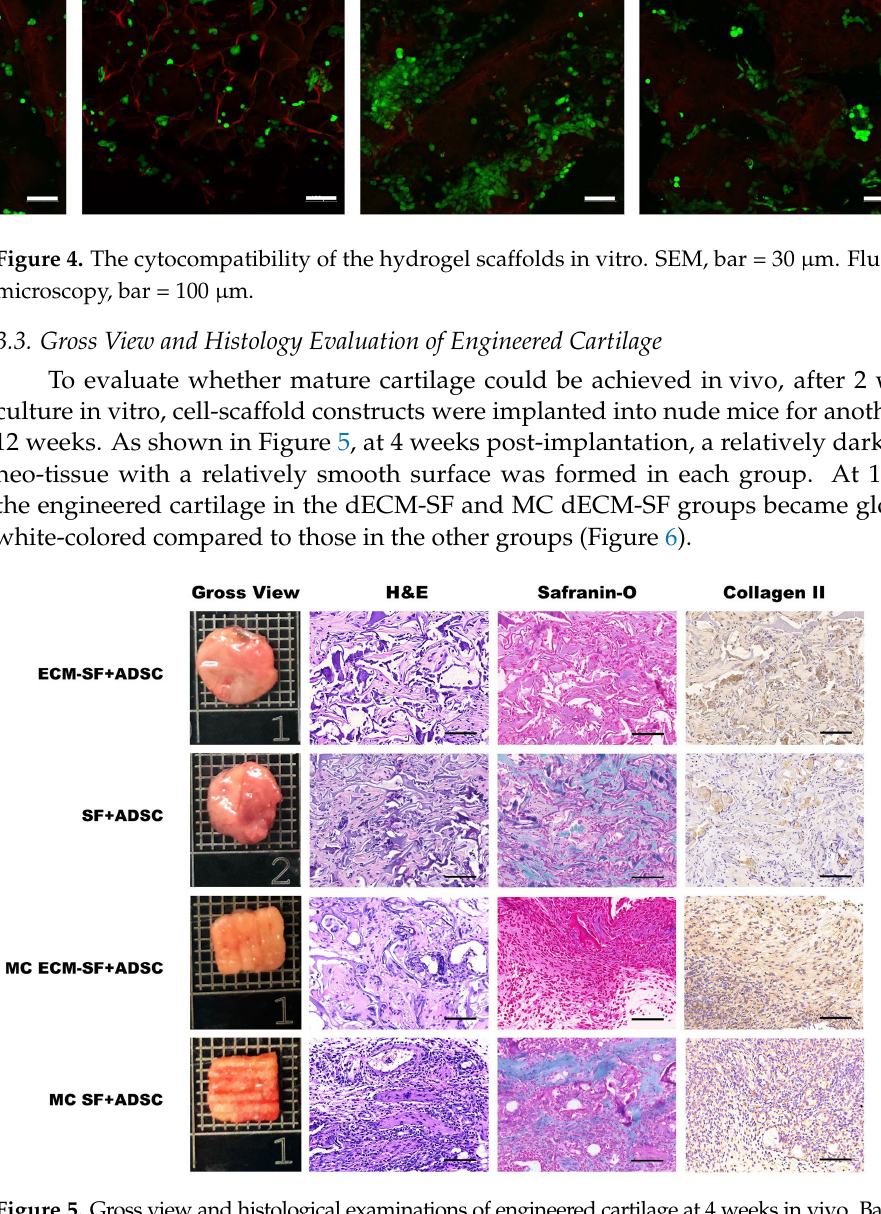
Figure 6. Gross view and histological examinations of the regenerated cartilage in nude mice for 12 weeks. Bar = 20 µm.